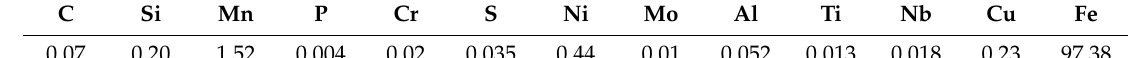
Table 1. Chemical composition of S420 steel (wt.%).